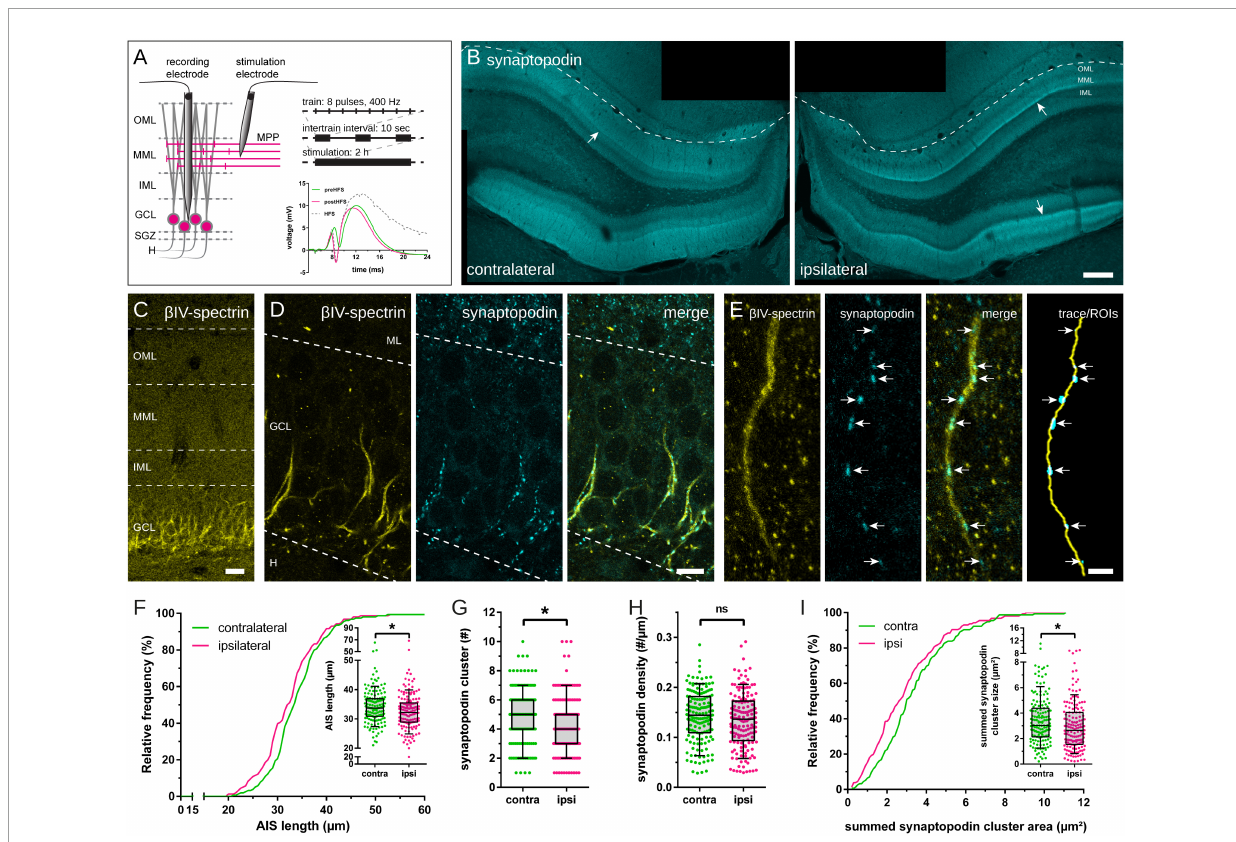
FIGURE1 Axon initial segment (AIS) and synaptopodin in granule cells (GCs) following 2 h high frequency stimulation (HFS) of the perforant path. (A) HFS (eight pulses at 400 Hz, 10 sec intertrain interval) was applied to induce long-term potentiation (LTP) of the medial perforant path for 2 h. Local field potentials of GCs were recorded before (green), during (gray) and after HFS (red) to estimate LTP induction. (B) Accumulation of synaptopodin in the middle molecular layer (MML; indicated by arrows) of the stimulated, ipsilateral dentate gyrus (DG) confirmed successful LTP induction. (C) The scaffolding protein β IV-spectrin was used to localize AIS of GCs and (D) co-labeling of synaptopodin revealed synaptopodin clusters within the AIS, indicative of cisternal organelles (CO). (E) AIS were reconstructed in image stacks, colocalized synaptopodin clusters (indicated by arrows) were identified and their largest cross-sectional area was measured. (F) AIS located in the ipsilateral hemisphere revealed a significant shortening following 2 h HFS. (G) The absolute number of synaptopodin clusters inside individual AIS decreased significantly, although synaptopodin cluster density remained unchanged (H) . (I) The total (summed) area of synaptopodin clusters in individual segments was significantly reduced following 2 h HFS. Number of segments: (F–I) n contralateral = 155, n ipsilateral = 156. Box and whiskers represents 10–90 percentile. * p < 0.05, Mann–Whitney test. Scale bars: (B) 200 µ m, (C) 25 µ m, (D) 10 µ m, (E) 2.5 µ m. GCL, granule cell layer; H, hilus; IML, inner molecular layer; ML, molecular